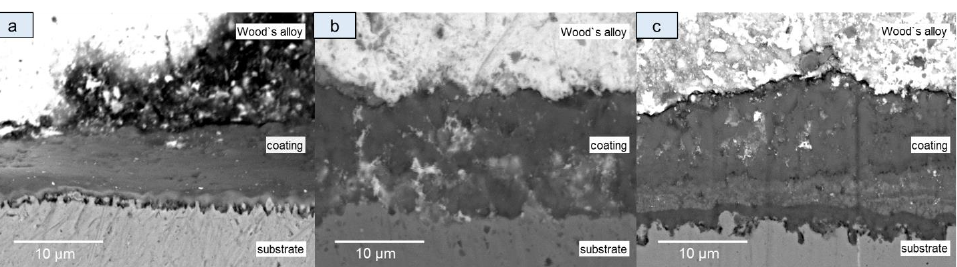
Table 4. Values of the oxidation rate constants of studied samples.